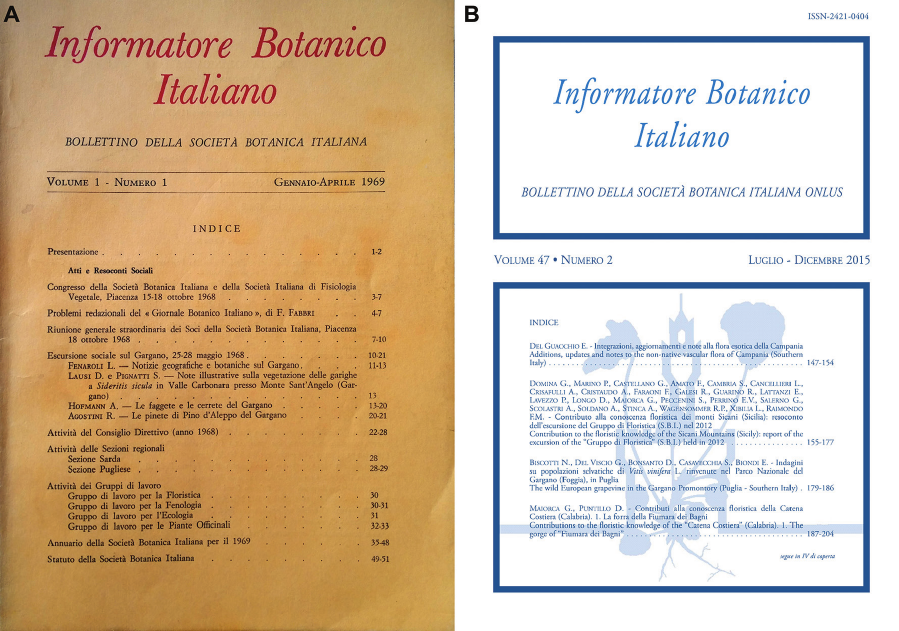
Figure 1. Front covers of the first issue of the “Informatore Botanico Italiano”, published in 1969 ( A ) and of the last issue of the “Informatore Botanico Italiano”, published in 2015 ( B